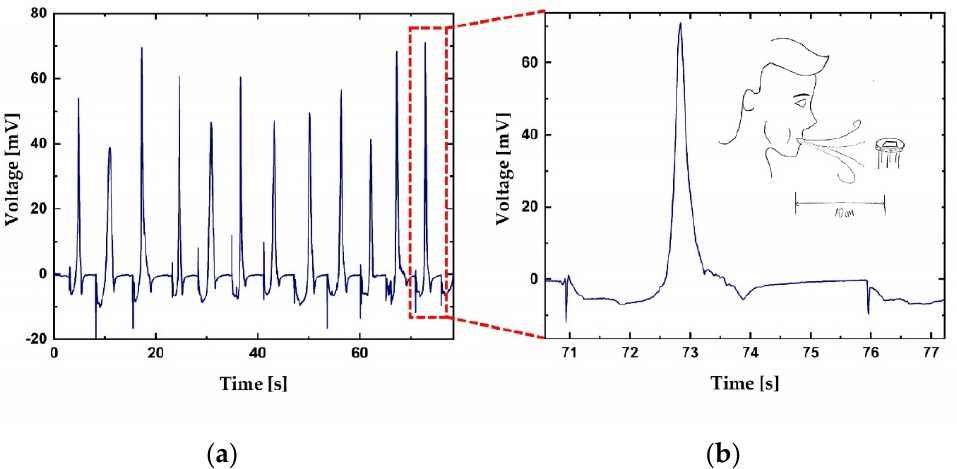
Figure 8. ( a ) Sensor’s response to periodical human exhalation from a 10 cm distance; ( b ) response to a single breath